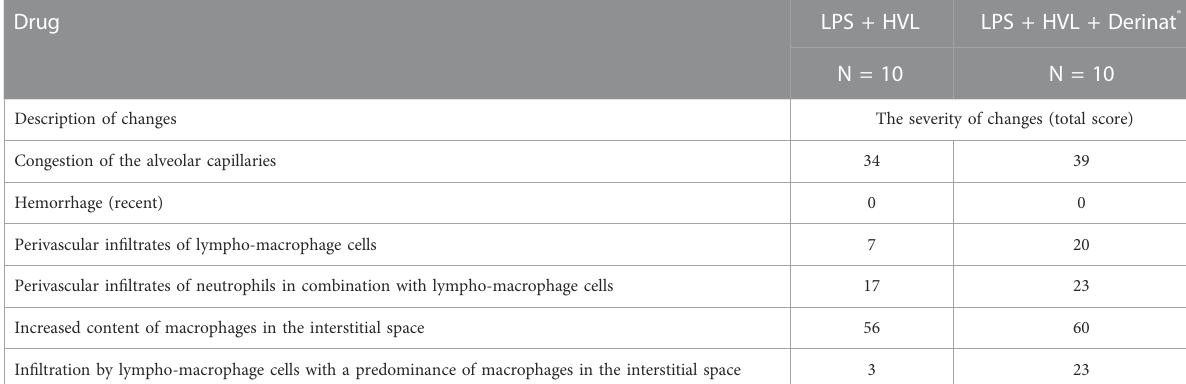
TABLE 2 The main pathomorphological changes in the lungs on the eighth day of the study.